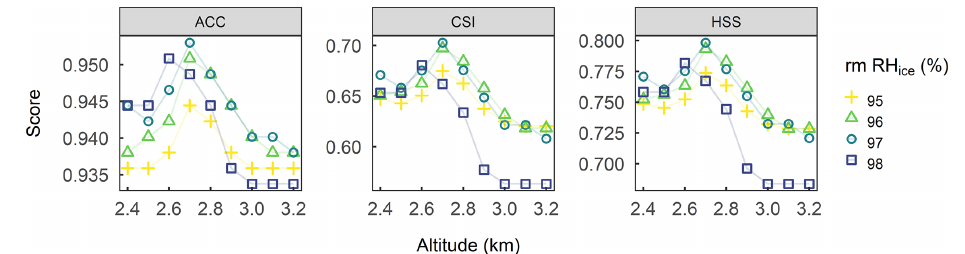
Figure 6. Scores to assess the prediction of snowfall using the running mean RH ice values and altitude ranges were best for running mean RH ice ≥ 97% throughout the lower 2.7km aboveground. A set of different lower threshold values was investigated ranging for a running mean RH ice from ≥ 95% to ≥ 98% throughout altitude ranges from ground-level to between 2.4 and 3.2km aboveground. Running means in RH ice were calculated of five consecutive 100m layers and the running mean was allocated to the lowest of the five layers. The following scores are shown: accuracy (ACC), critical success index (CSI), and Heidke skill score (HSS). See Table A1 for more information on the